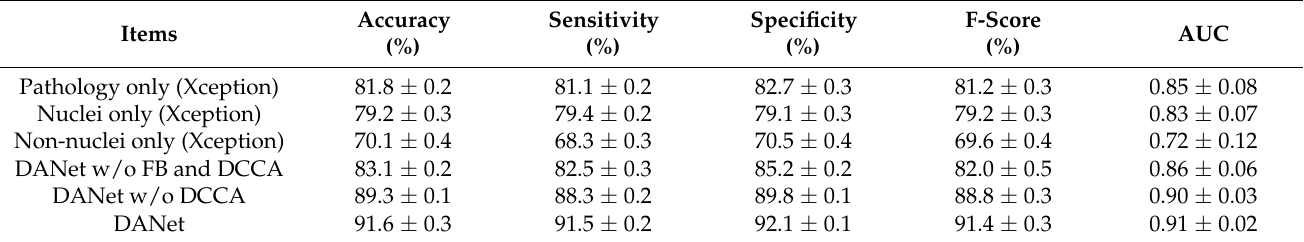
Table 4. Ablation study on the fusion block (FB) and DCCA